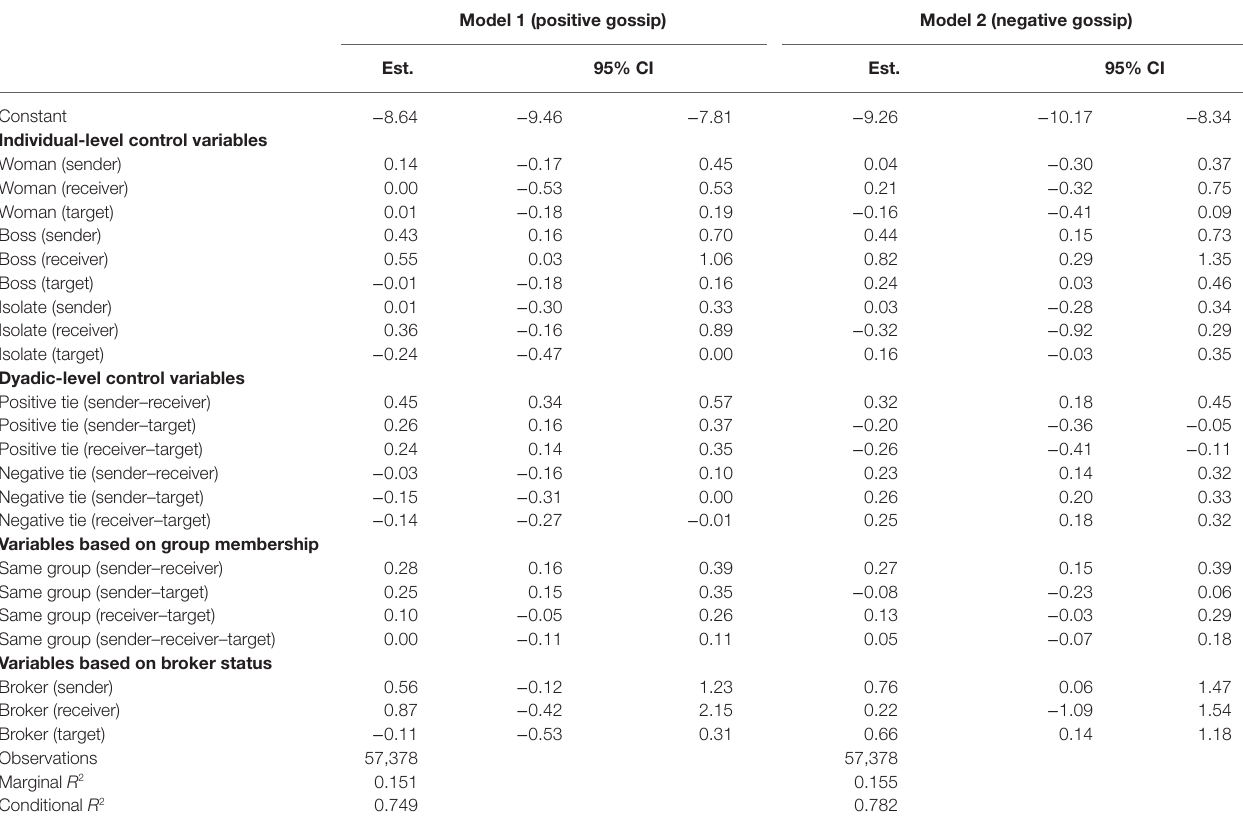
Marginal R 2 indicates the proportion of the model variance explained by the fixed effects only. Conditional R 2 indicates the proportion of the model variance explained by the fixed and random